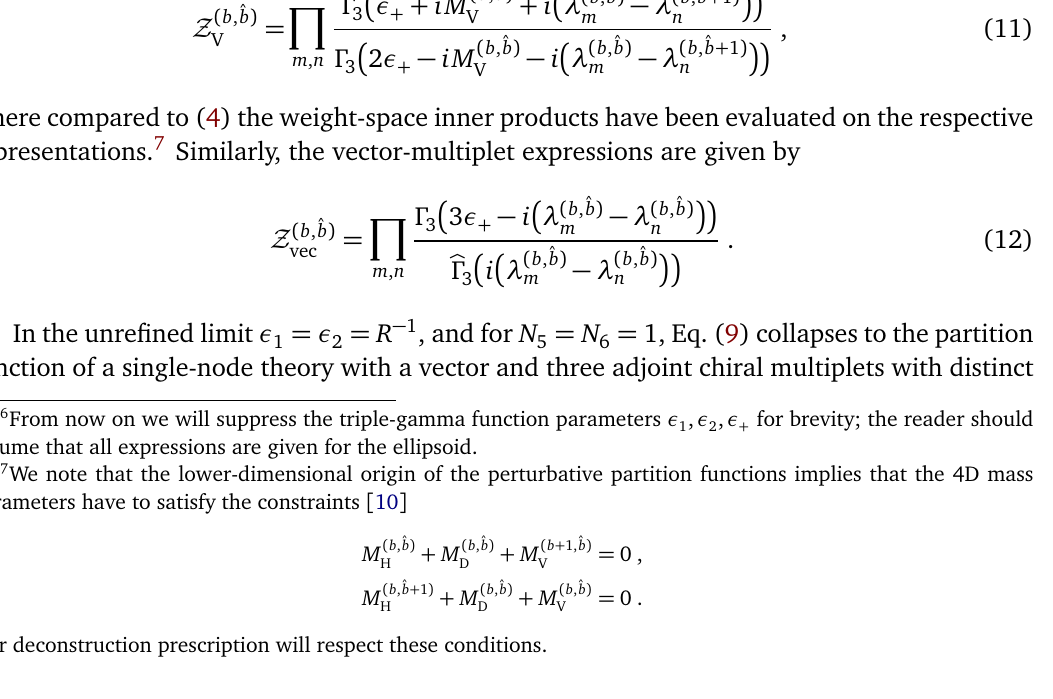
Figure 2: The quiver diagram for the (cid:90)